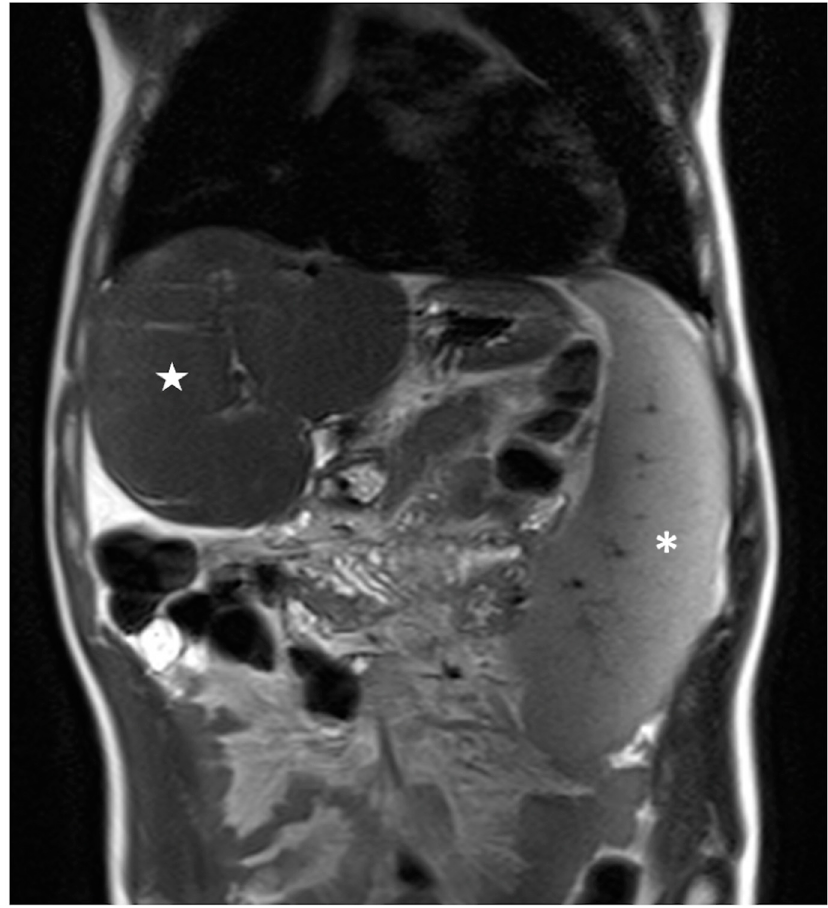
Figure 5. Coronal T2-weighted image of a patient belonging to Group 2 showing large splenomegaly with a total volume of 829 cm 3 (white asterisk); conversely, the liver shows a reduced volume of 760 cm 3 (white star).